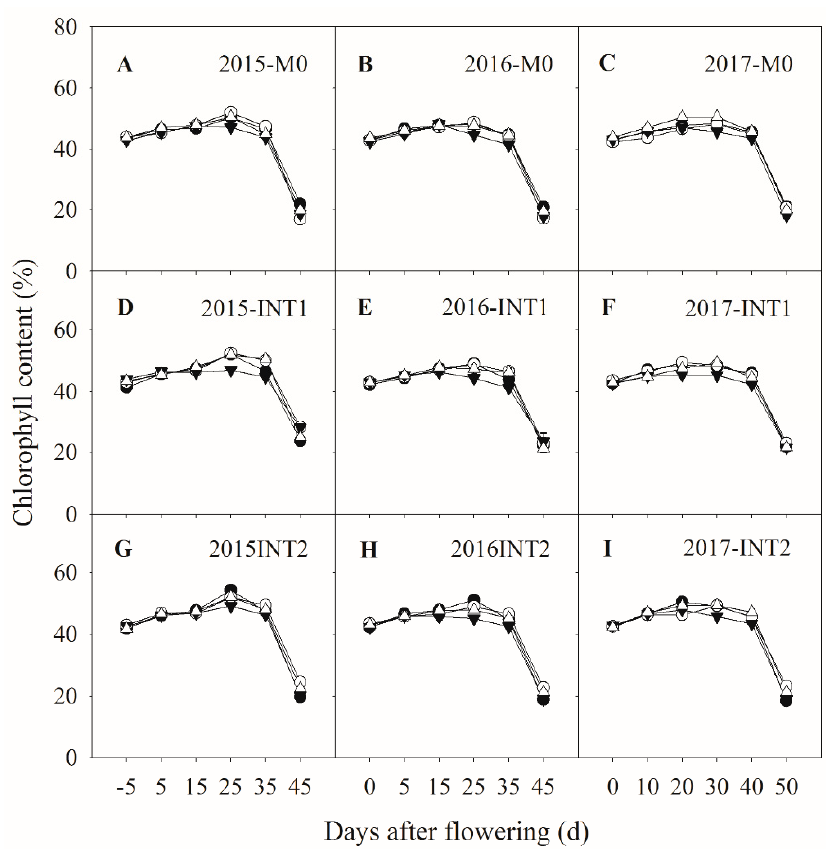
Figure 4. Dynamic changes of chlorophyll content (SPAD values) for the different soybean cultivars ( ● : HD19; ○ : HD20; ▼ : ZH39, and △ : QH34) under the M0 ( A ), INT1 ( B ) and INT2 ( C ) at days after flowering during 2015–2017. Each value is the mean ( n = 9) ± S.E.